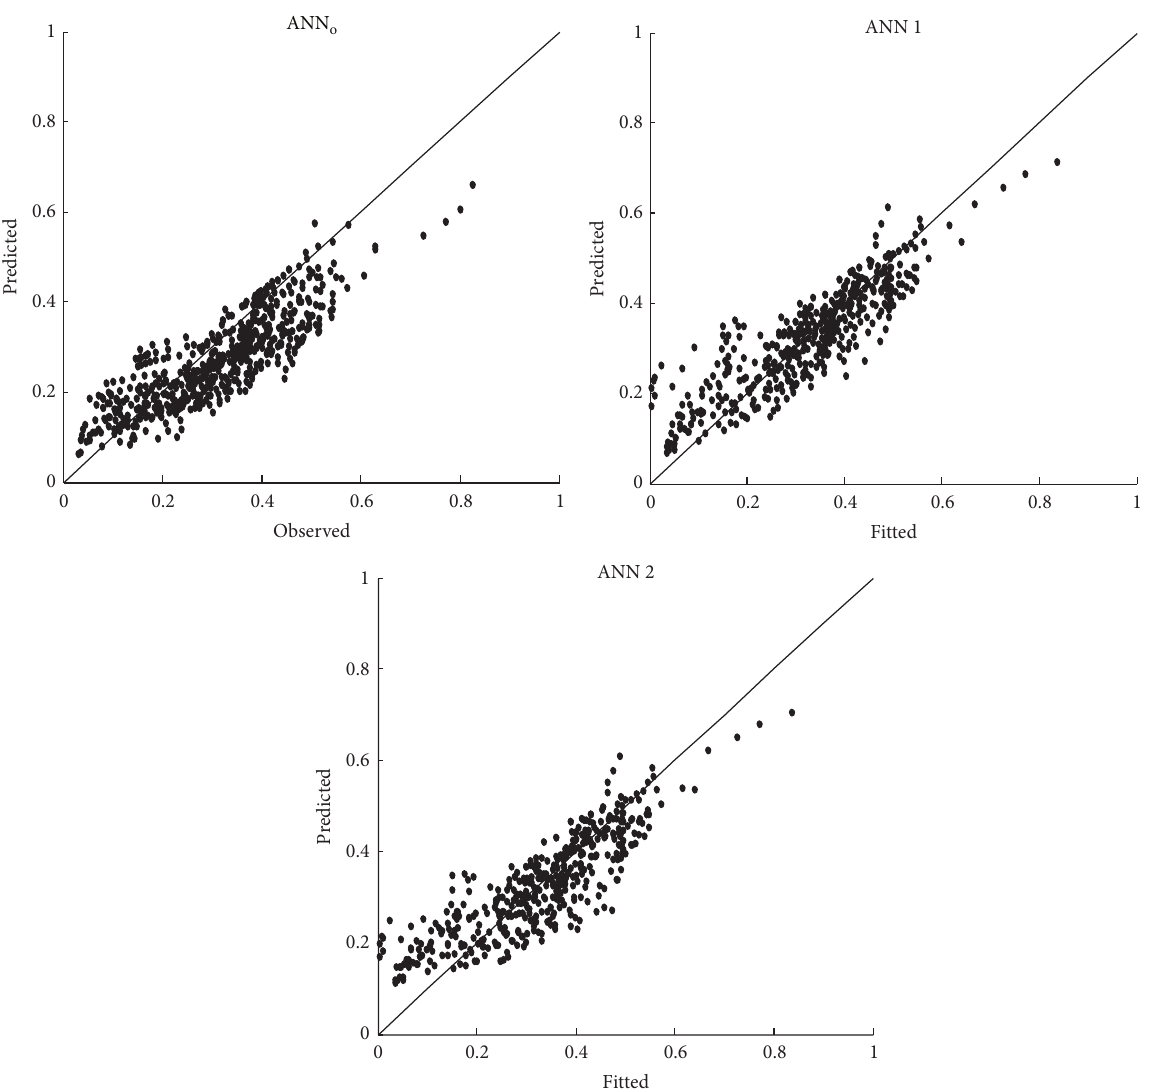
Figure 4: Scatter plots of fitted (ANN 1 and ANN 2 models) and observed (ANN 3) versus predicted water contents (cm 3 cm −3 ) for all matric